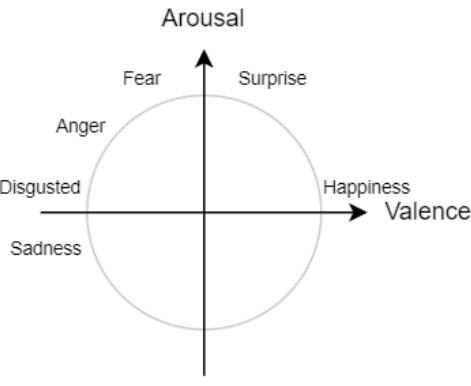
Figure 3. Ekman’s emotions on Circumplex model (own elaboration based on [81]).